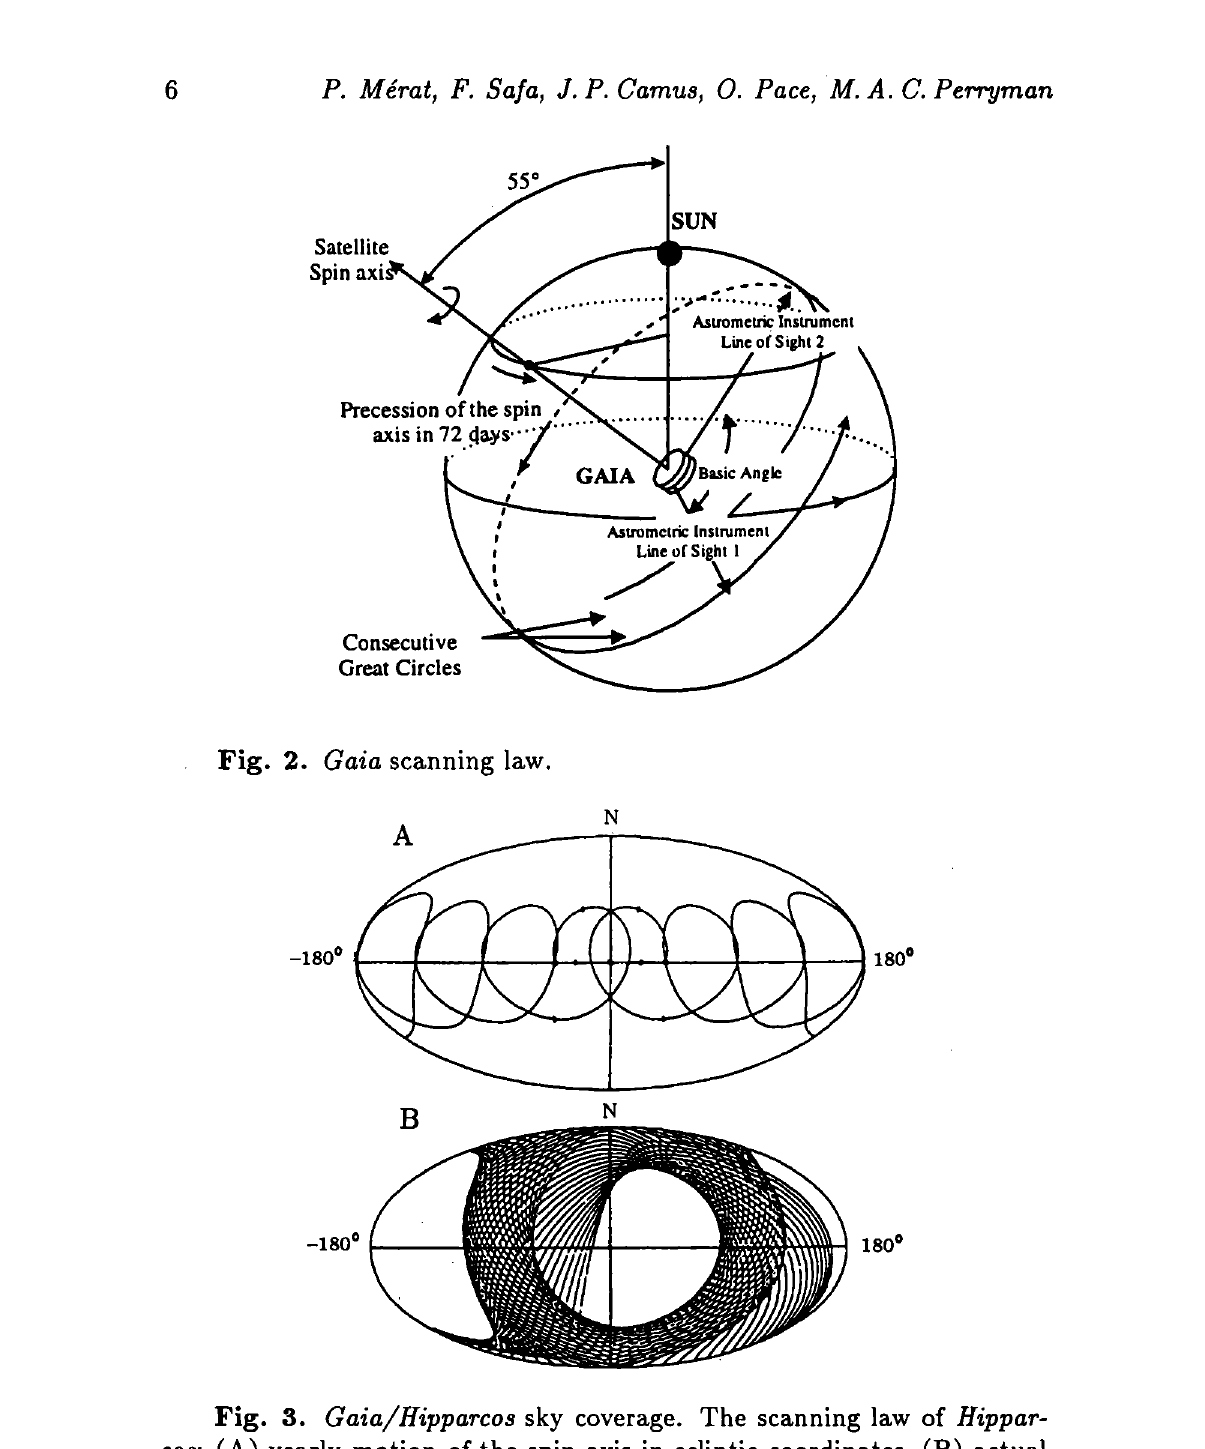
Fig. 3. Gaia/ffipparcos sky coverage. The scanning law of Hippar- cos : (A) yearly motion of the spin axis in ecliptic coordinates, (B) actual scanning during one rotation of the spin